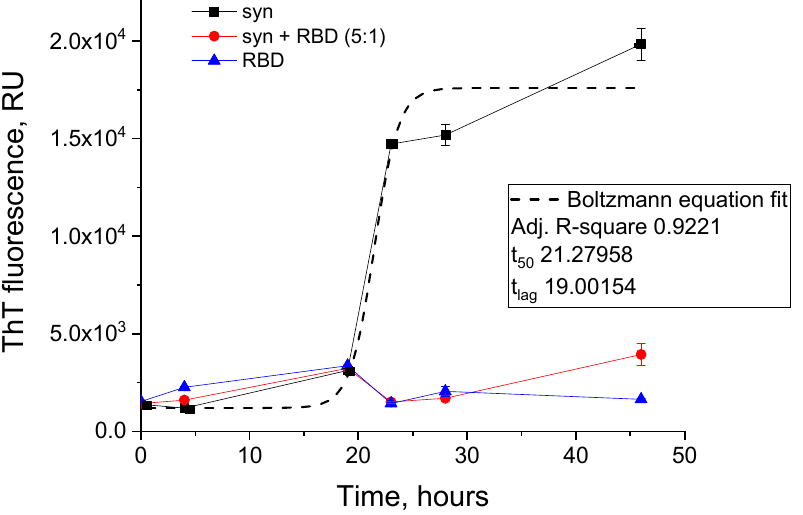
Figure 6. ThT fluorescence fibril formation kinetics of alpha-synuclein in the absence and presence of SARS-CoV-2 RBD. ThT fluorescence of 5.6 µ M SARS-CoV-2 RBD (triangles), 28 µ M alpha-synuclein (squares), 28 µ M alpha-synuclein and 5.6 µ M SARS-CoV-2 RBD (molar ratio 5:1, circles).